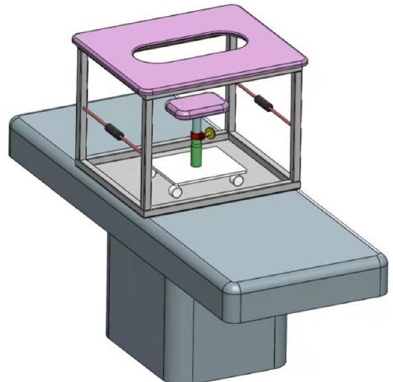
Figure 2. A special prone positioning frame designed specifically for real-time US with prone MRI virtual navigation. US = ultrasound; MRI = magnetic resonance imaging.